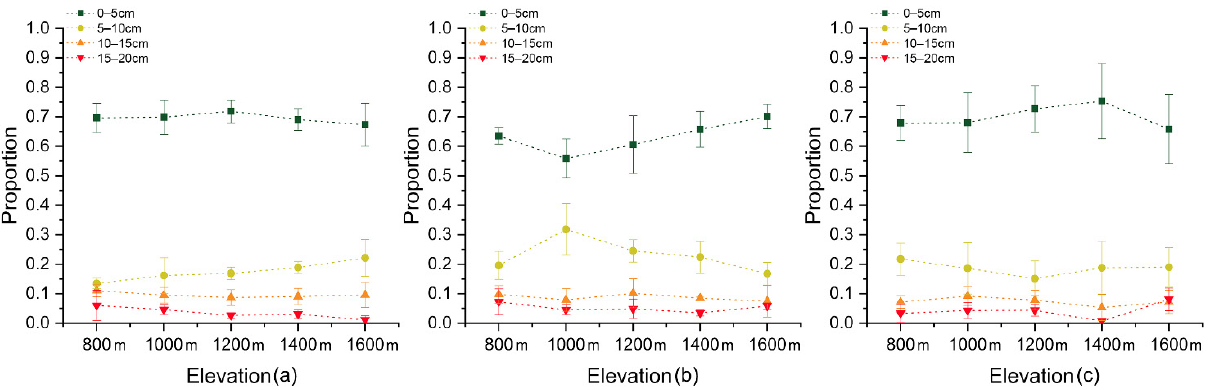
Figure 5. Abundance proportion of lifeform in understory vegetation ( a ) and soil seeds in April ( b ), July ( c ) and October ( d ) with elevation. T = tree, V = vine, S = shrub, SS = semi-shrub, PH = perennial herb, ABH = annual–biennial herb, AH = annual herb.